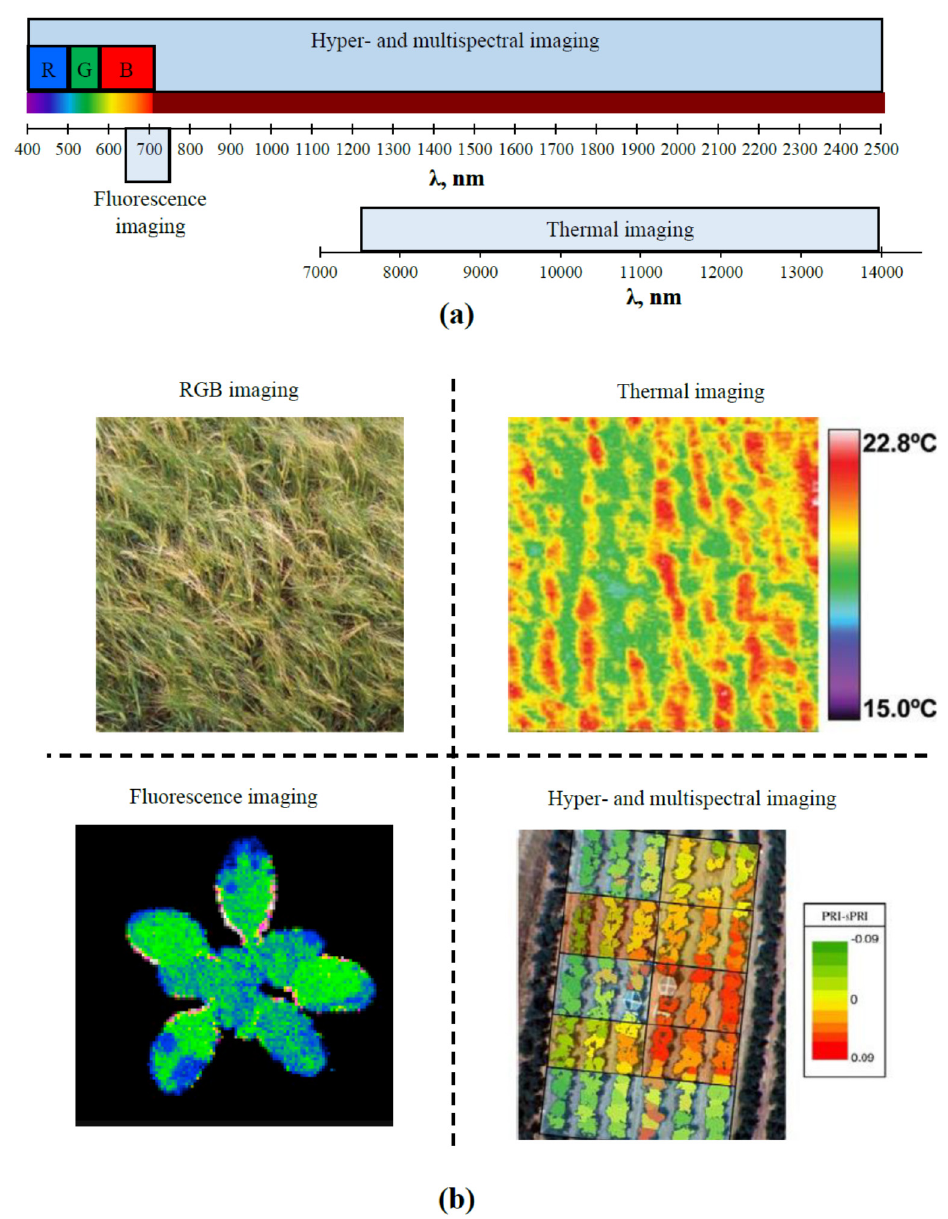
Figure 1. The optical methods of estimation of growth and development, physiological processes, and biochemical composition of plants, including the RGB, thermal, fluorescence, and spectral imaging. ( a ) Spectral ranges of these optical methods. ( b ) Examples of using the RGB imaging, the thermal imaging, the imaging of the chlorophyll fluorescence, and the spectral imaging of reflected light. These examples are based on works [24–26]. R, G, and B are the red, green, and blue spectral bands of the reflected light that are measured at the RGB imaging.